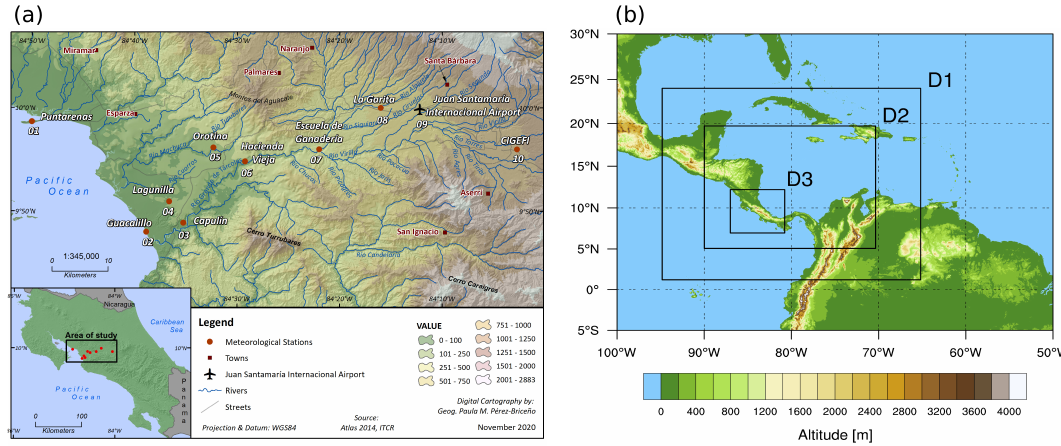
Figure 1. ( a ) Topographical map of the Grande de Tárcoles river basin. Red markers show the location of the meteorological stations used in this study. The numbers correspond to the station identifiers in Table 1. ( b ) The MM5v3 domain configuration. D1, D2, and D3 correspond to 27, 9, and 3 km grids,